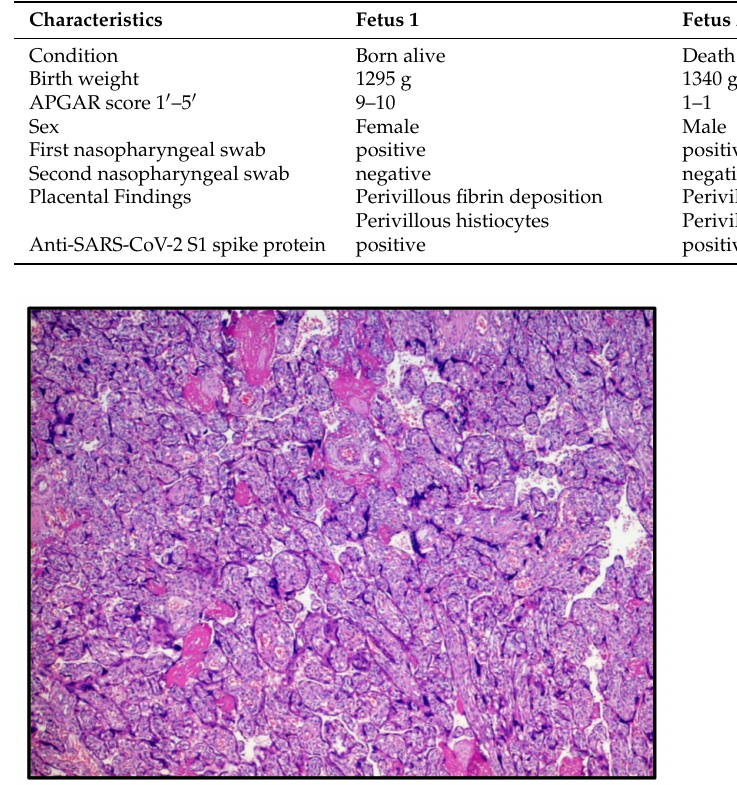
Figure 1. Histological features of the first chorionic disc: deposition of intervillous fibrin and chorionic villi corresponding to the gestational age (30 weeks). Hematoxylin-Eosin, 10 ×